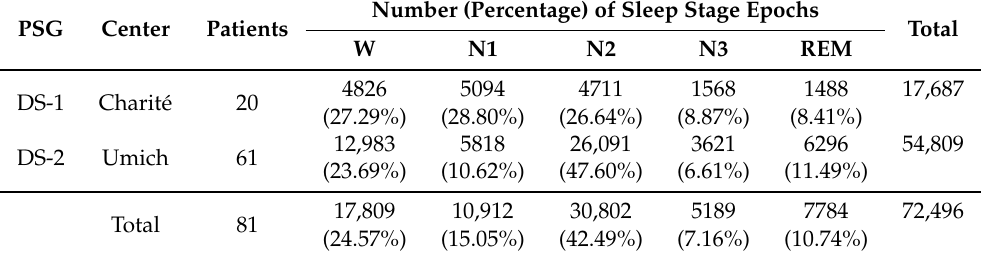
Table 1. Distribution of sleep stages corresponding to different sleep epochs in the data sets used in the study. PSG Center